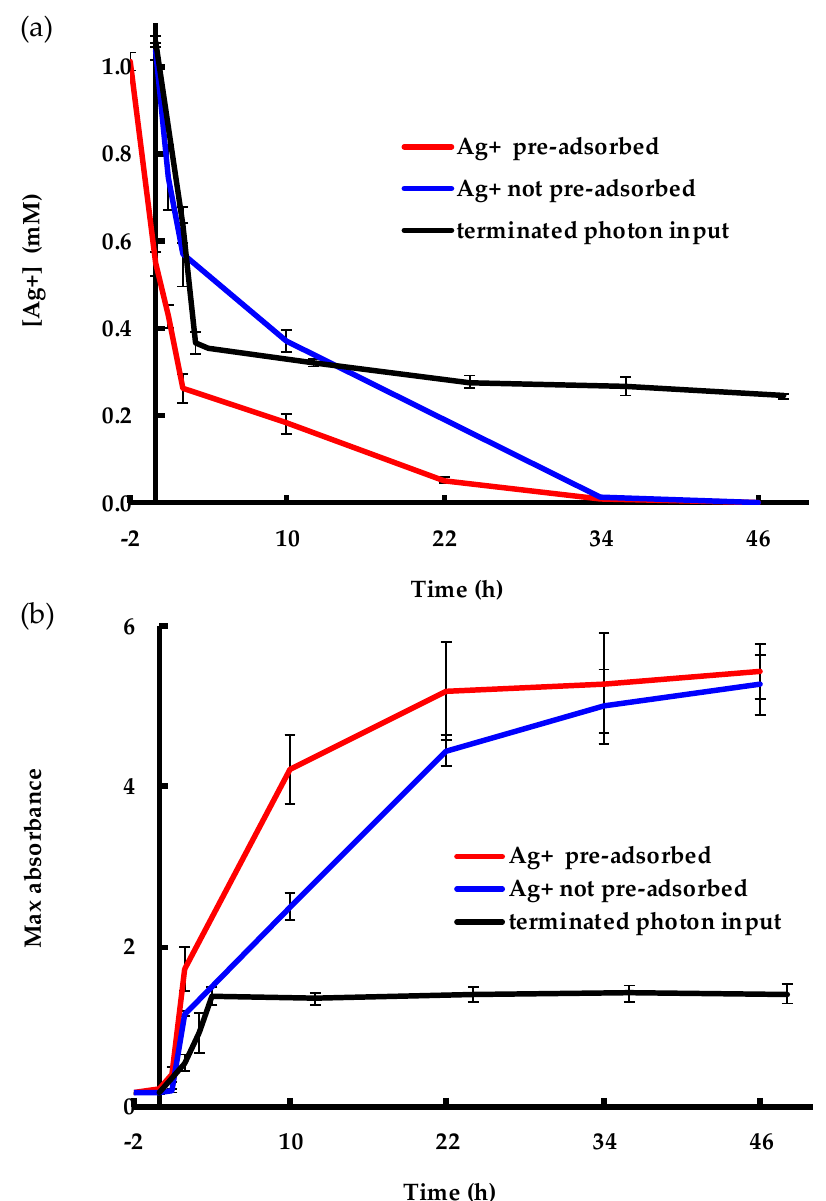
Figure 10. The results from the three experiments showing ( a ) consumption of Ag + and ( b ) SPR development of the AgNPs over time.